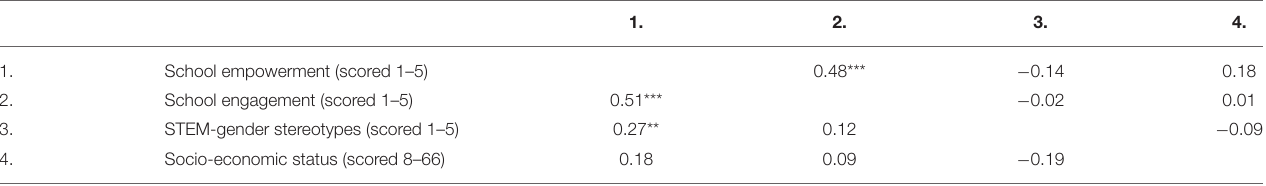
TABLE 2 | Pearson’s bivariate correlations for the Italian sample.